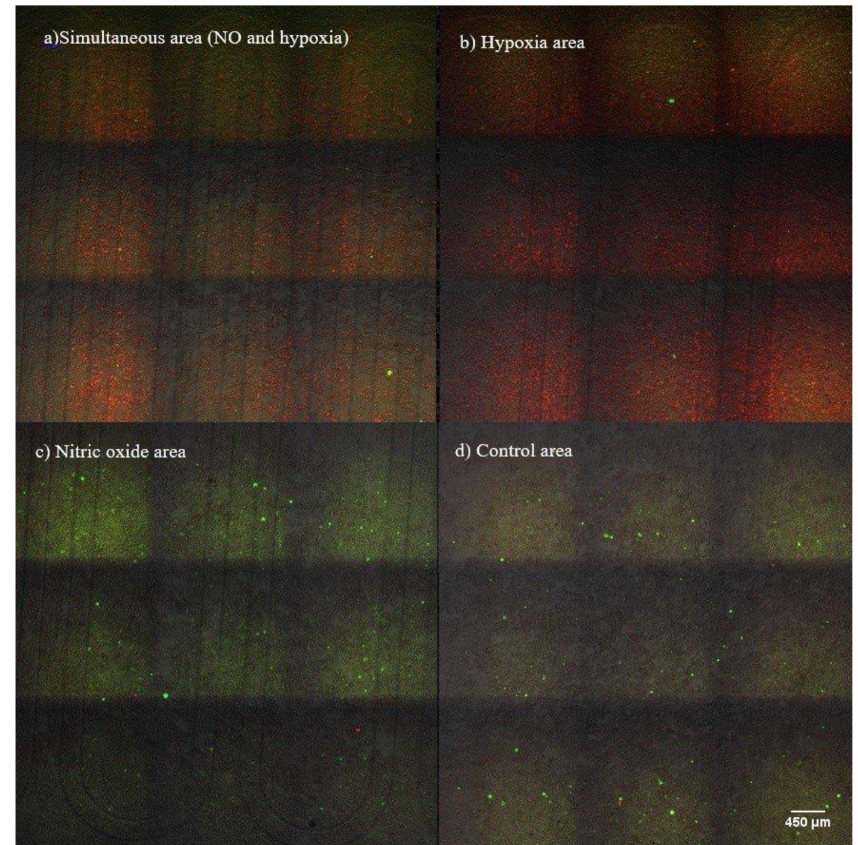
Figure 10. Fluorescence signals from the four di ff erent microenvironments achieved by the second microchip design. ( a ) Simultaneous response to nitric oxide and hypoxia. ( b ) Only hypoxia cell response. ( c ) Only nitric oxide cell response. ( d ) Signal from control area without treatments (image magnification: 100 ×